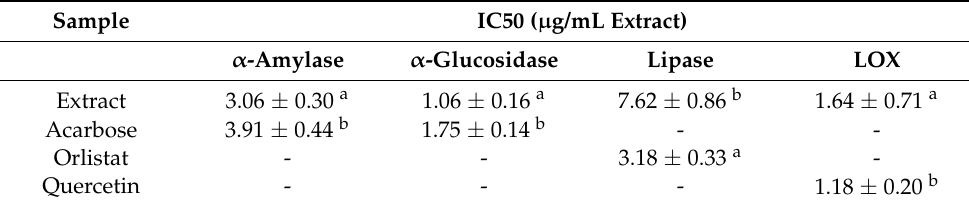
Table 7. The inhibitory capacity (IC50 values; µ g/mL) of the red grape skin extract on α -amylase, α -glucosidase, lipase, and lipoxygenase (LOX) activity before thermal treatment. Sample